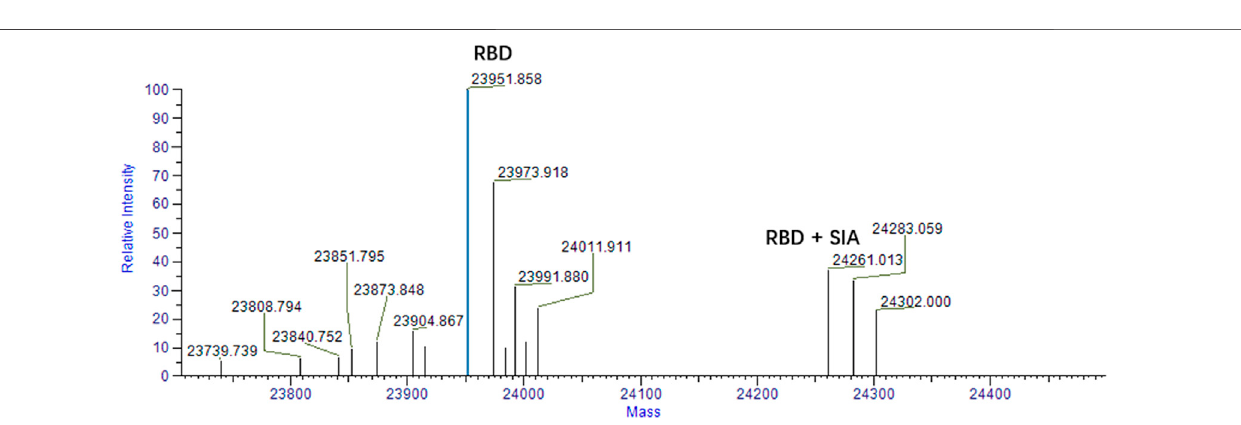
FIGURE5| MassspectrumanalysisofRBDand sialicacidbindingcomplex.Thepeak at 23,951representstheRBD domain. Theligand-protein bindingcomplex is shown by the peak 24261 m/z. The condition for analysis is RBD: SIA (cid:1) 1:50.